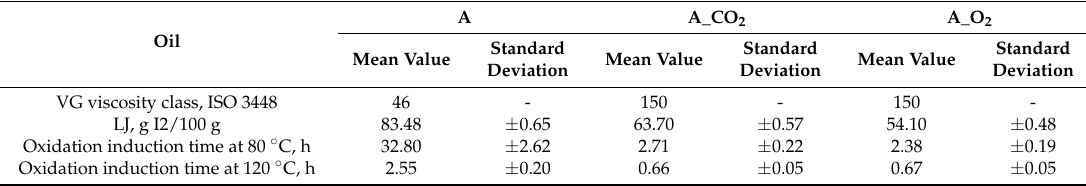
Table 2. Properties of the starting materials and results of the PetroOxy tests. A A_CO 2 A_O 2 Oil Standard Standard Mean Value Mean Mean Value Deviation Deviation